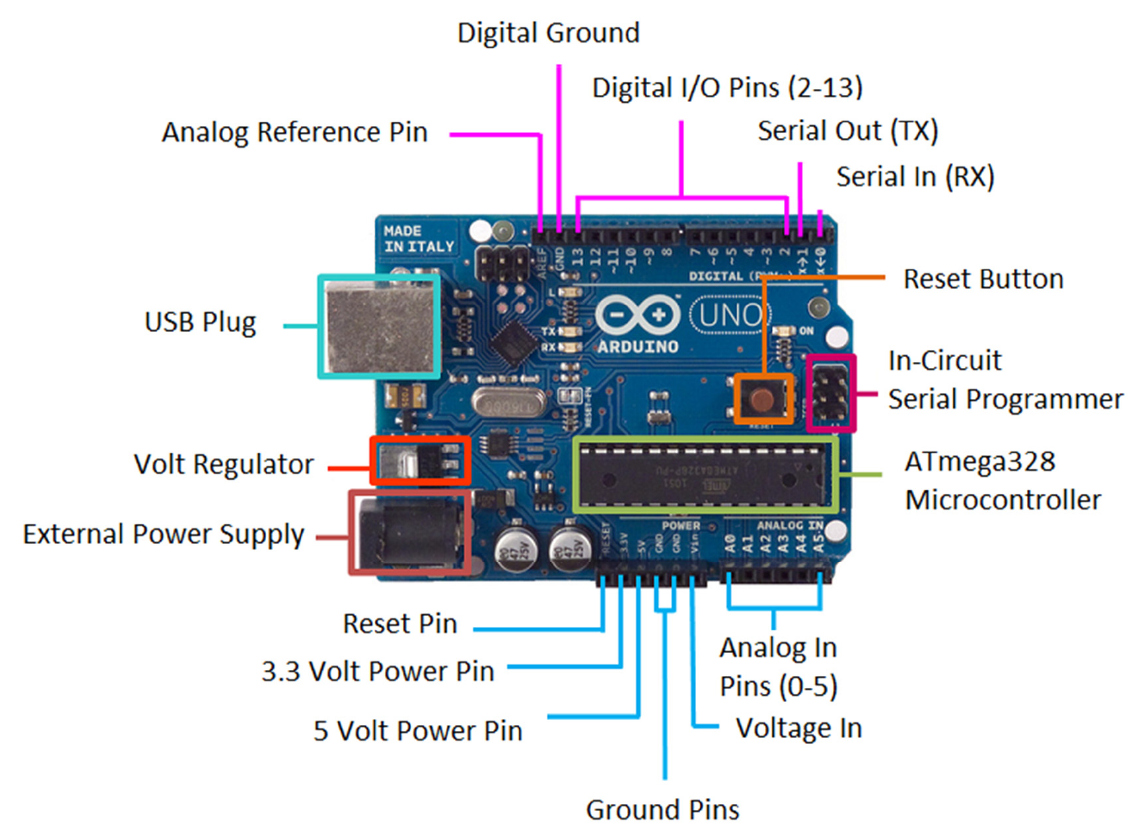
Figure 15. Arduino UNO data logger.